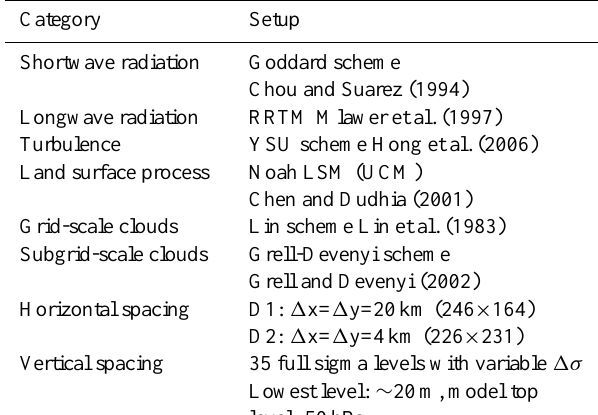
Table 1. Experimental setup for the WRF simulations.